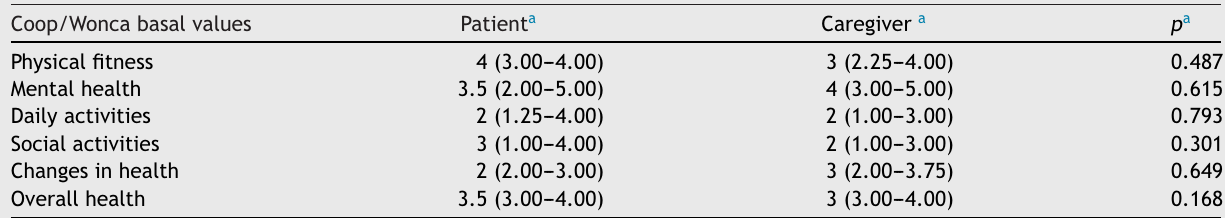
Comparison of the domains of the Coop/Wonca questionnaire between patients with head and neck cancer and their caregivers.